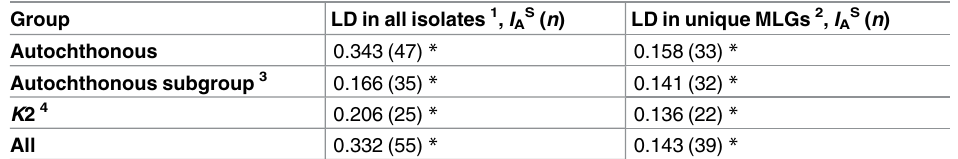
A summary of LD values, as measured by the Index of Association ( I AS ), for samples grouped by autochthonous versus imported origin, and population structure, is presented in Table 4. High LD was observed amongst the 47 autochthonous P . vivax samples with 9-locus MLGs ( I AS = 0.343, P < 0.01). Assessment of the 33 unique MLGs in this group revealed lower LD but remained moderately high and significant ( I AS = 0.158, P < 0.01). Exclusion of the 12 identical MLGs in the autochthonous group, also resulted in lower LD but again remained significant when all 35 isolates were included ( I AS = 0.166, P < 0.01) and when the 32 unique MLGs were considered ( I AS = 0.141, P < 0.01). Owing to insufficient marker diversity amongst the isolates with high ancestry to K 1 (S4 Table), and subsequent confounding effects on the Index of Table 4. Linkage disequilibrium.